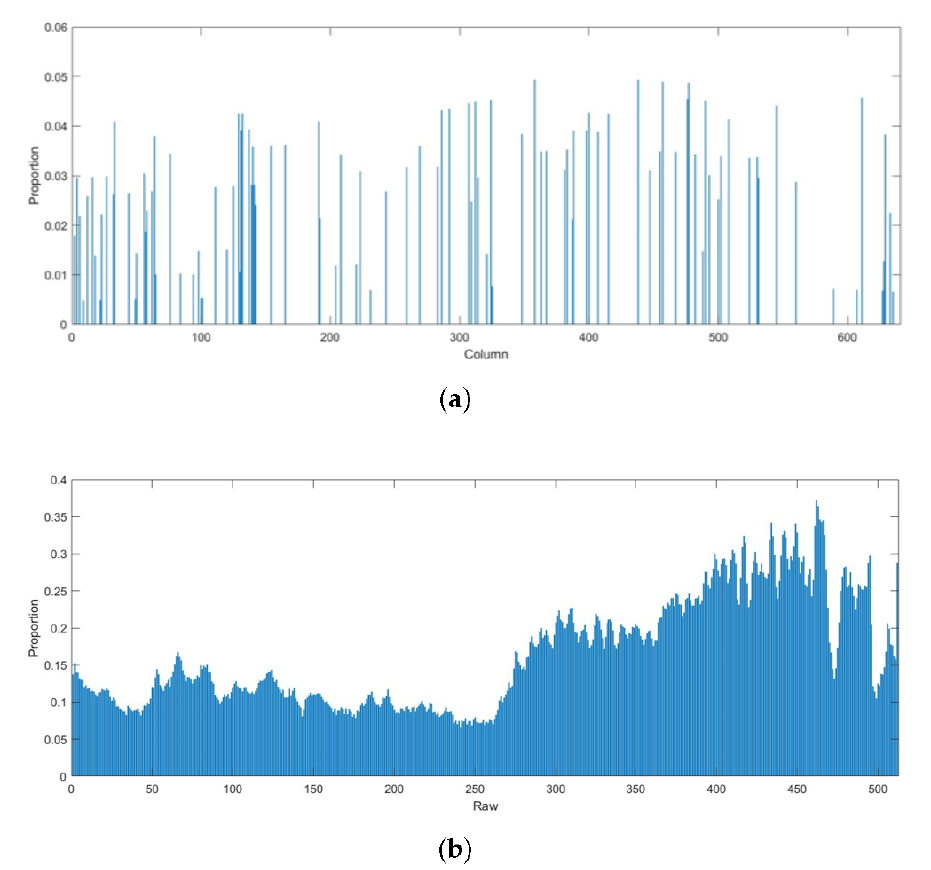
Figure 3. Difference between proportion of the L1-norm for information components and stripe noises: ( a ) Proportion of the L1-norm for each column of noise components in the L1-norm for the vertical gradient of the original image; ( b ) Proportion of the L1-norm for each row of information components in the L1-norm for the horizontal gradient of the original